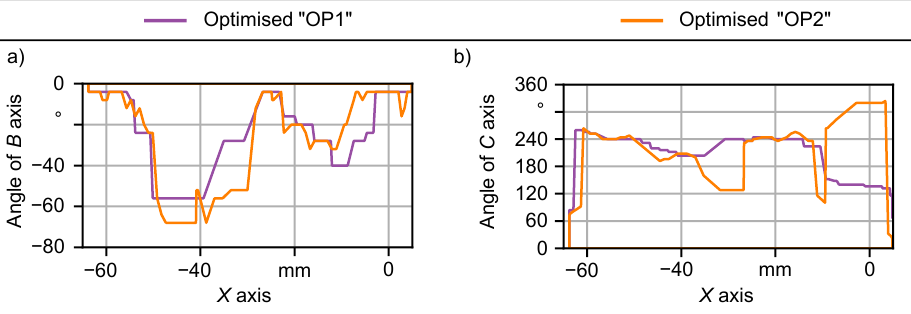
Figure 14. Angle of ( a ) B and ( b ) C axis adjustment along the optimised NC paths OP1 and OP2.